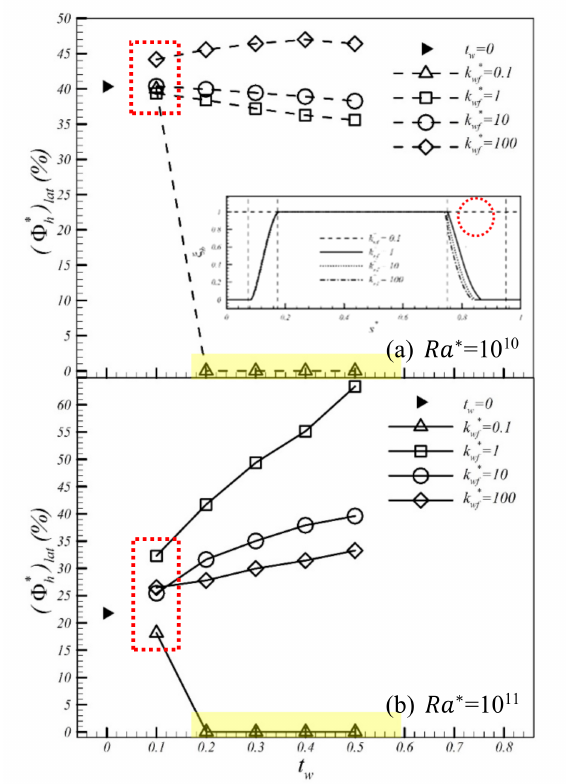
(cid:16) (cid:17) Φ ∗ versus wall thickness t w for di ff erent k ∗ h lat = 0.4, l = 0.75, Sb ∗ = 0.6, Ste ∗ = 0.1, and c z h